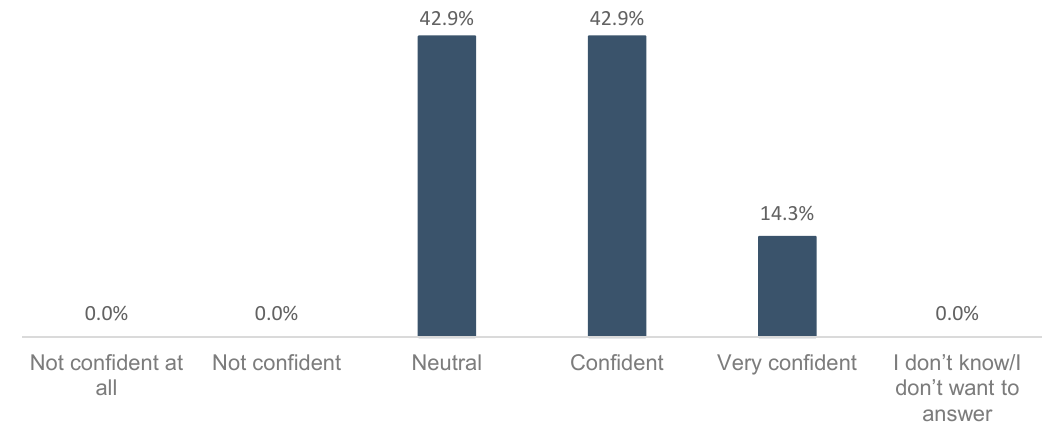
Figure 14. Solution for anonymity.